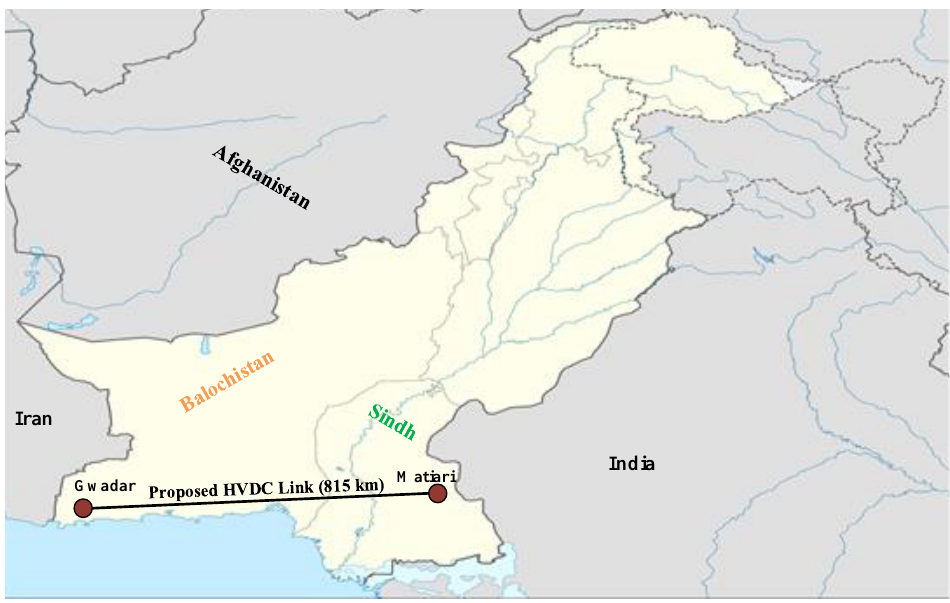
Figure 2. Proposed HVDC transmission line for the South-western part of Pakistan.